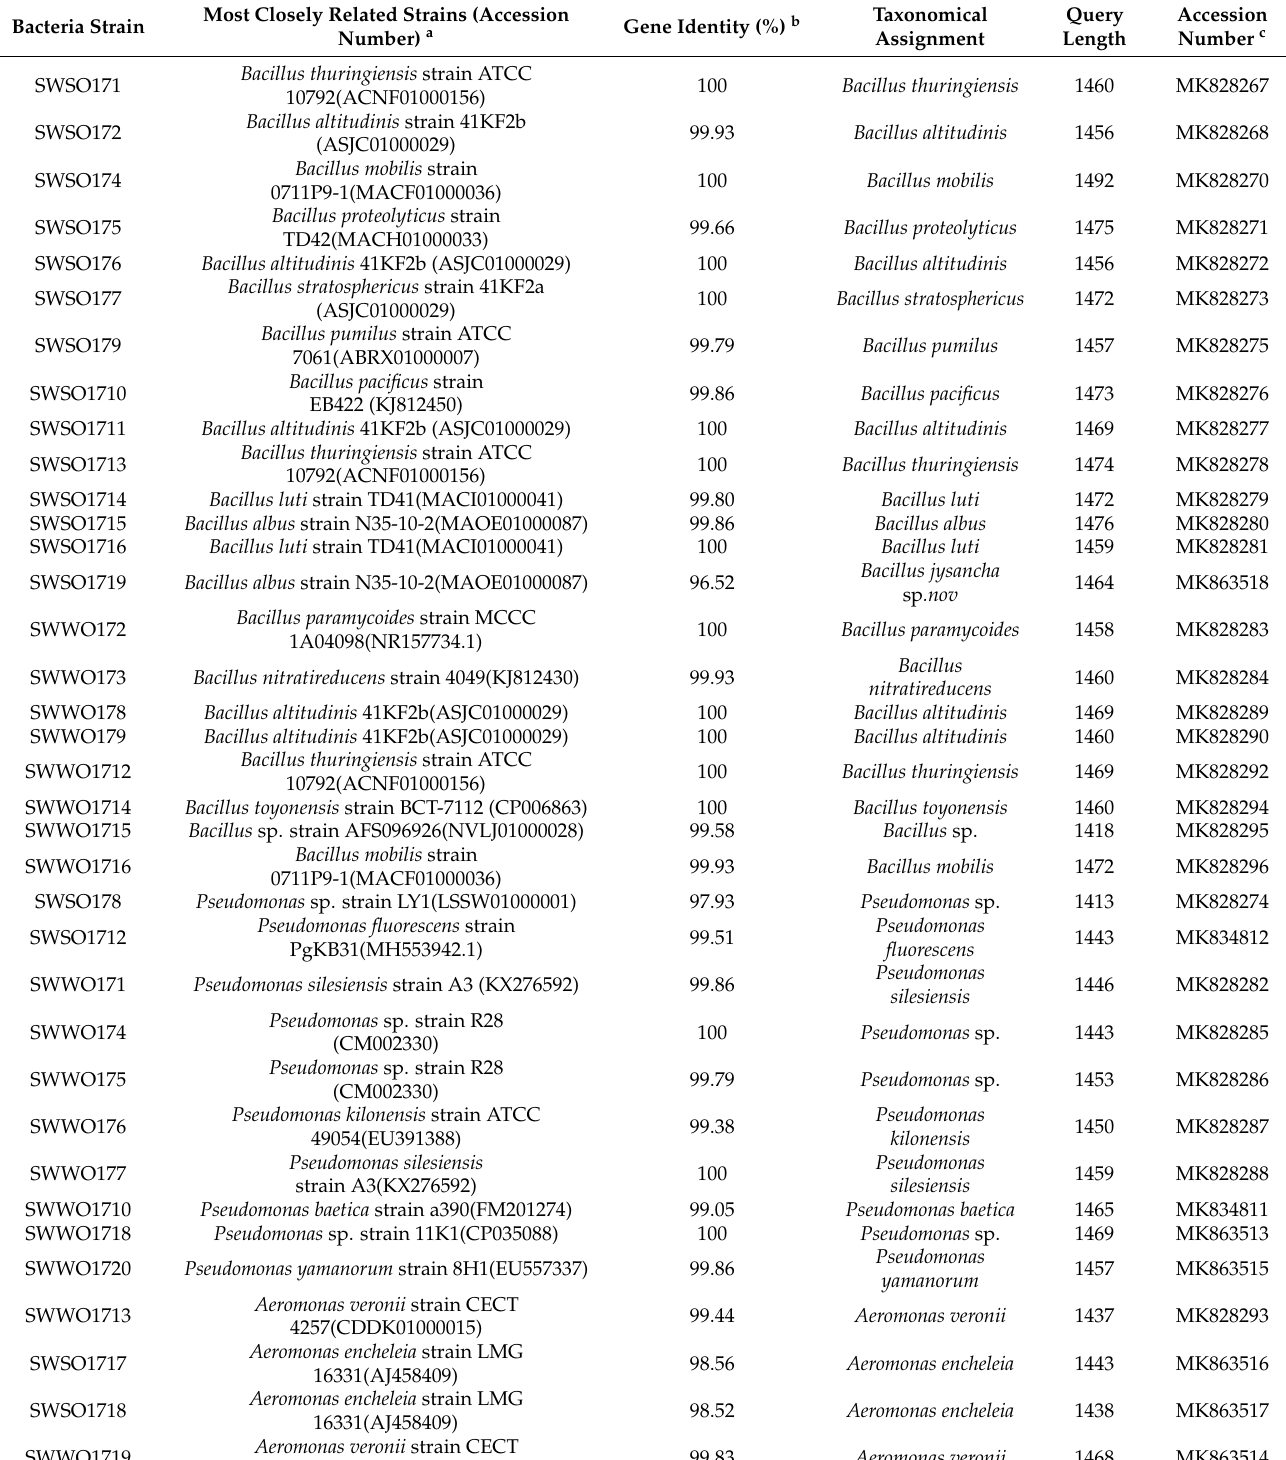
Table 1. Online BLAST results of 16S rDNA sequences for the 39 OPB strains in the sediments of Sancha